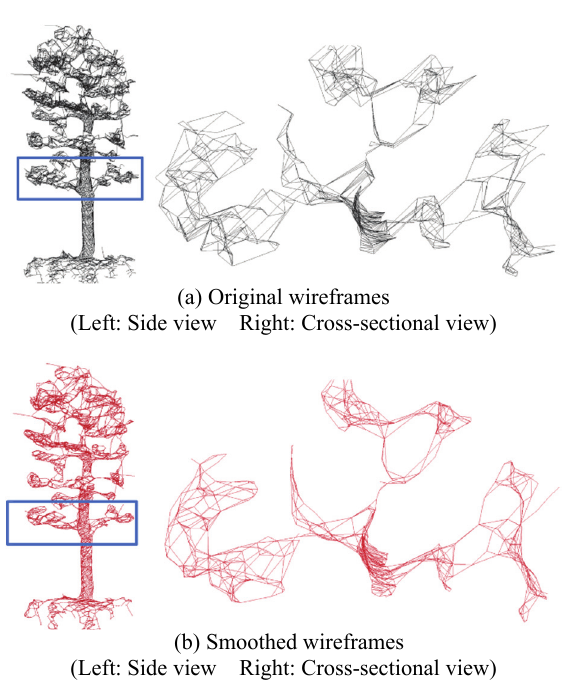
Figure 7 . Comparison of original wireframes and Taubin filter smoothing applied